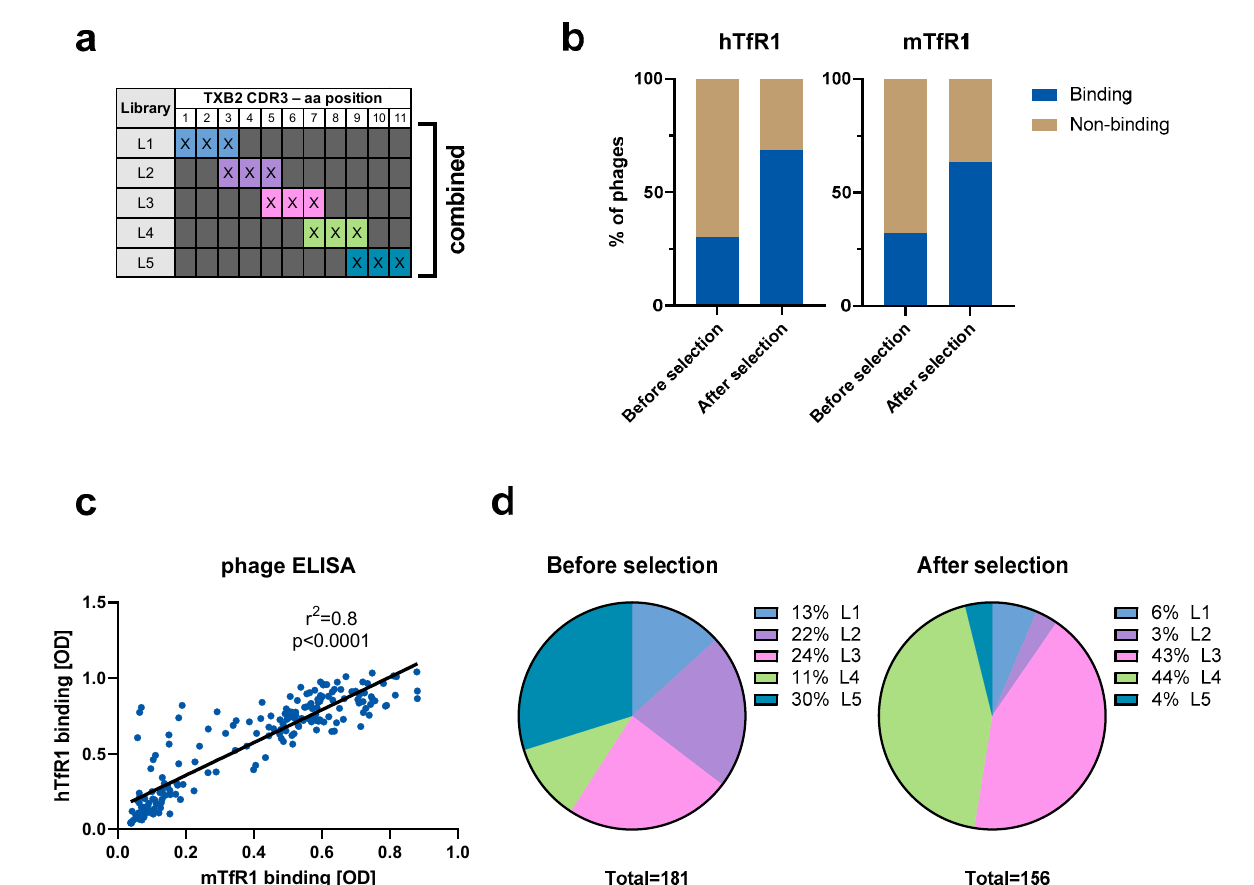
Figure 1. TXB2 maturation library design and selection. ( a ) Schematics of the CDR3 region of TXB2 antibody randomized in segments of three residues (X—any amino acid) per sub-library. Total of five sub-libraries L1–L5 were prepared individually before combining them and using for the selection against hTfR1. ( b ) Phage ELISA results presented as the percentage of binders to hTfR1 and mTfR1 from randomly picked clones before and after selection (round 1 output). ( c ) Pearson’s correlation analysis of phage ELISA-based binding of selected clones to hTfR1 and mTfR1. ( d ) Distribution of CDR3 sub-libraries in randomly picked clones from before and after selection.